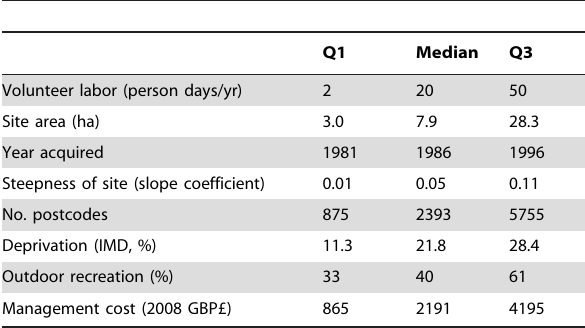
Table 1. Variation in volunteer effort and sample protected area